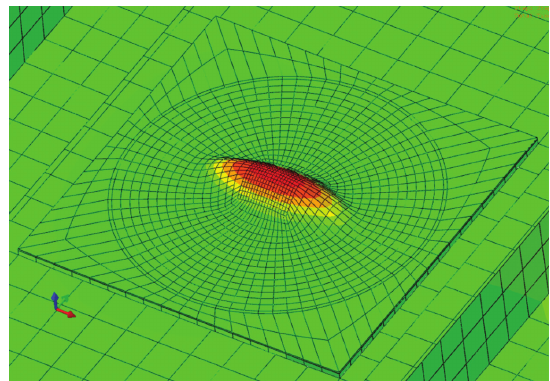
Figure 4 View of the delamination